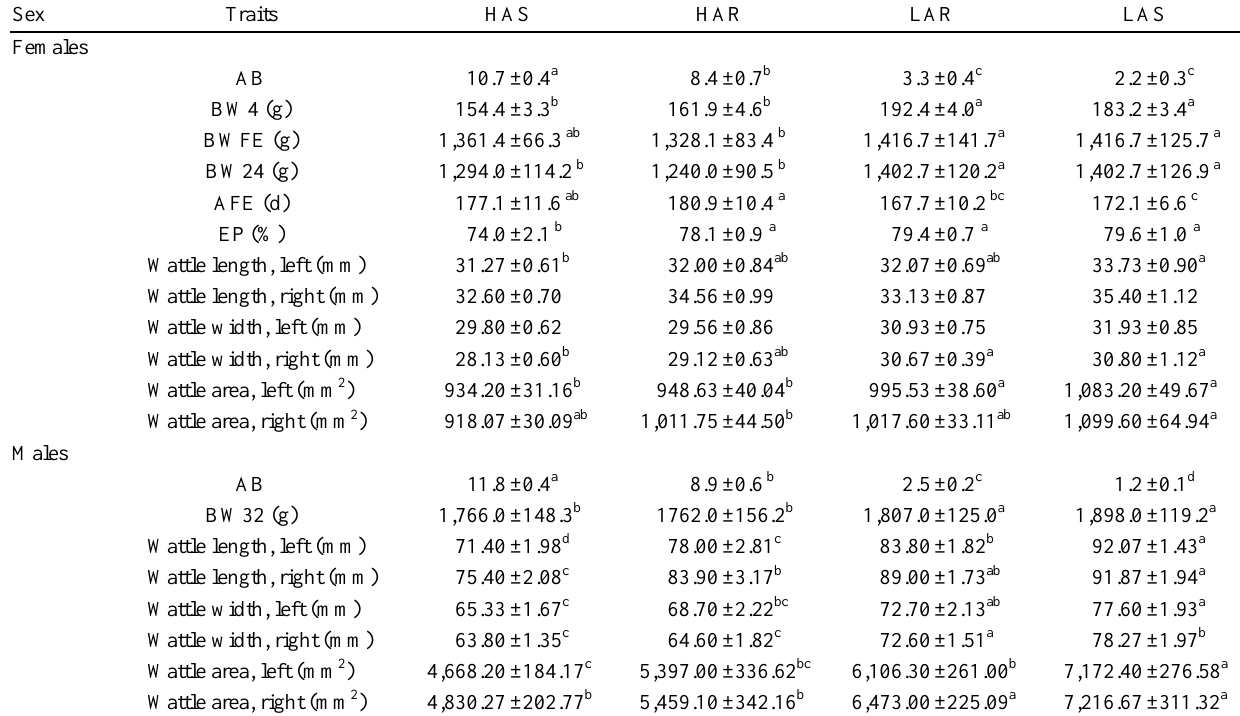
Table 1. Means±SE of traits for females and males by line 1 Sex Traits HAS HAR LAR LAS